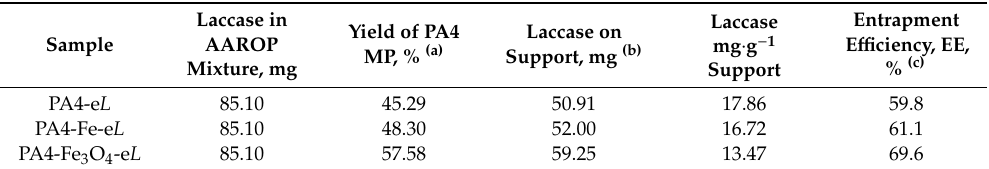
Table 5. Enzyme quantification in PA4@eL